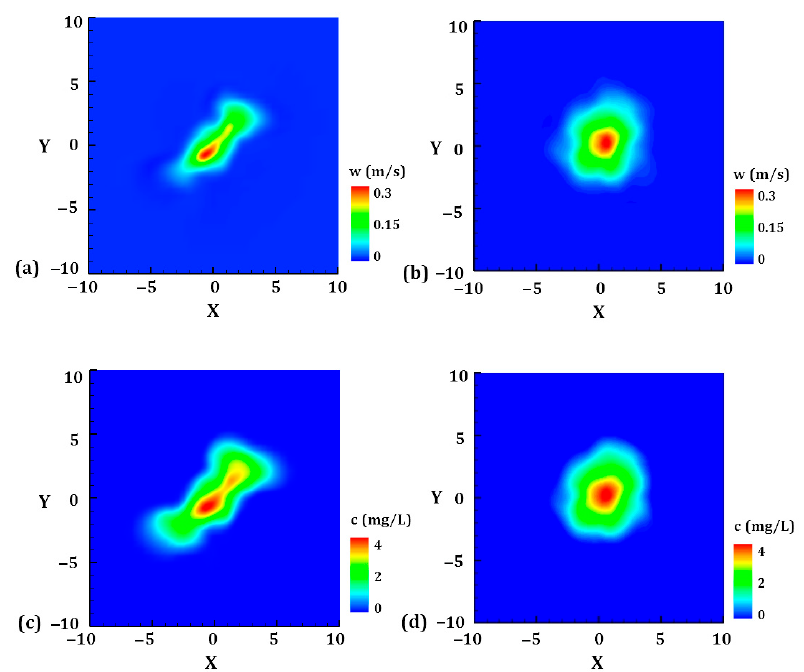
Figure 5. The mean vertical velocity ( a , b ) and concentration ( c , d ) profiles of jets at Z = 20 in Case A0. The results of ( a , c ) are simulated by the azimuthal forcing method, and the results of ( b , d ) are simulated by the trigonometric function disturbance (TFD) method.